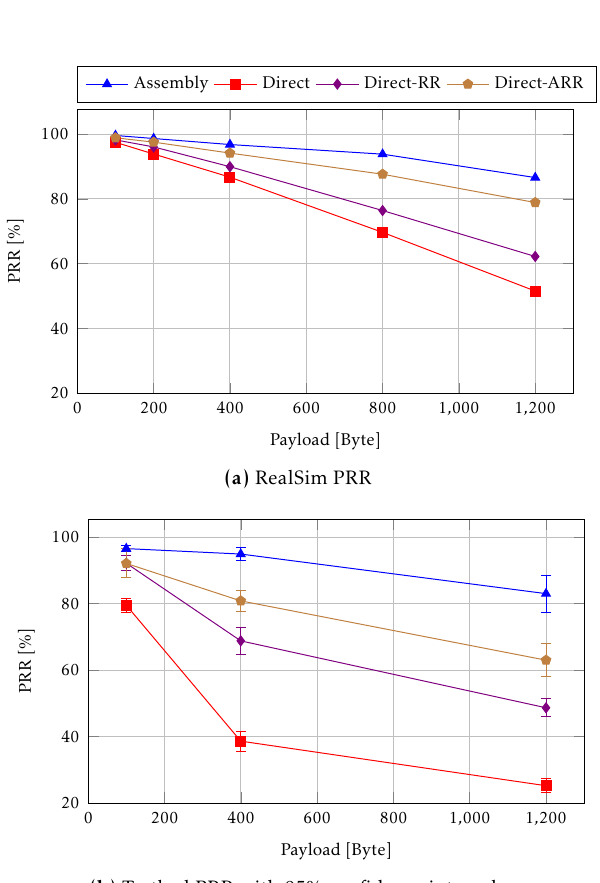
(b) Testbed PRR with 95% confidence intervals Figure 10. Comparing the packet reception rates of the RealSim and the Testbed Network with a byterate of 37 . 5 B/s ; second set of